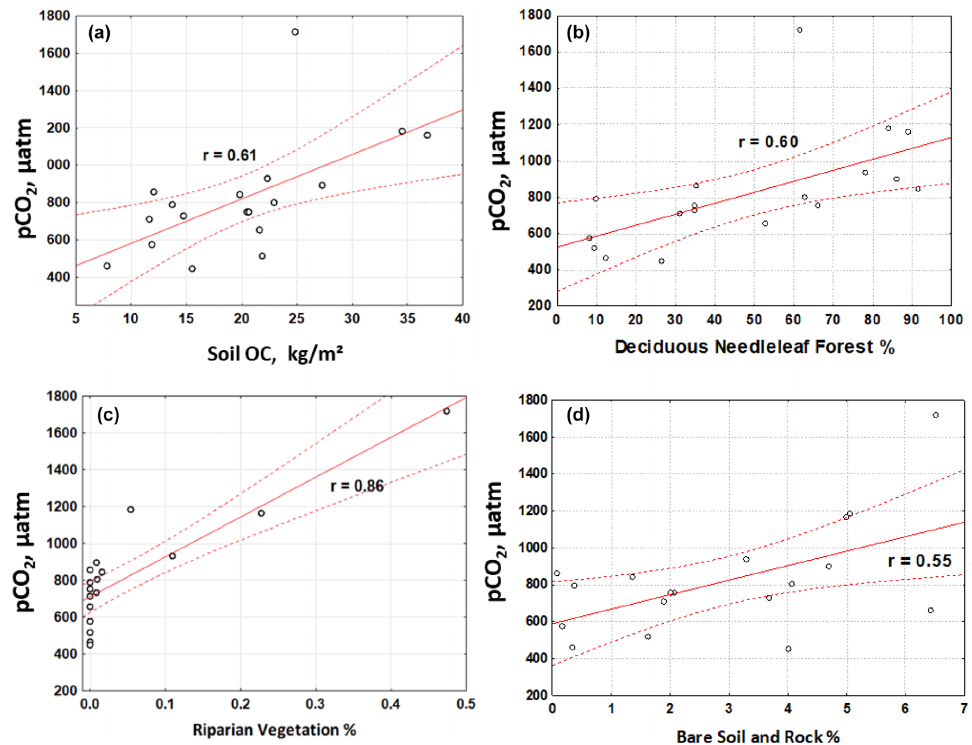
Figure 5. Significant ( p < 0 . 05) positive control of landscape parameters – OC stock in 0–100cm of soil (a) , and proportion of deciduous needleleaf forest (b) , riparian vegetation (c) , and bare soil and rock (d) in the watershed for p CO 2 in the Lena River